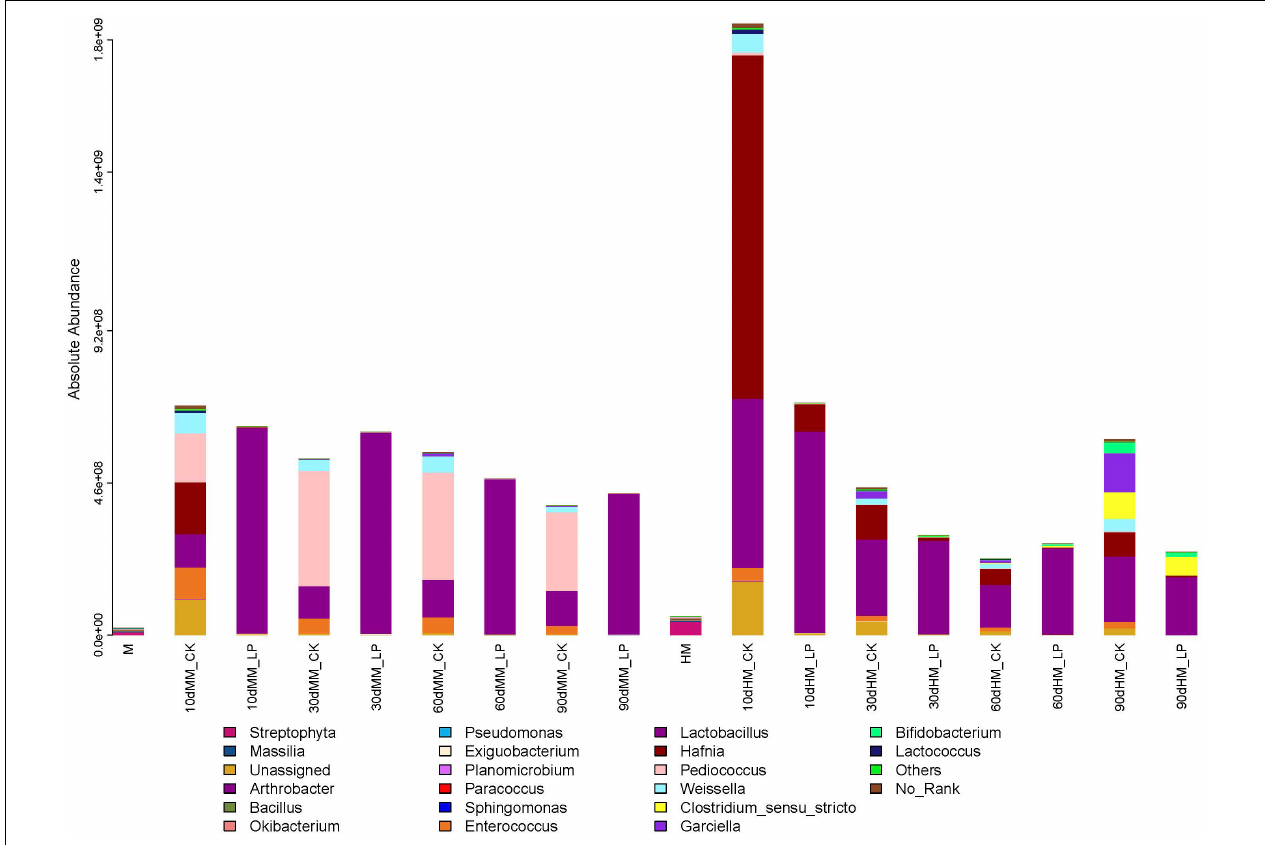
FIGURE 5 | Bar plots of bacterial community structures in alfalfa silage at 10, 30, 60, and 90 days. Genus with proportions in bacterial community below 1% were combined as “Others.” HM, not wilted before ensiling; MM, wilted before ensiling; CK, silage without inoculation; LP, silage inoculated with L. plantarum A345.